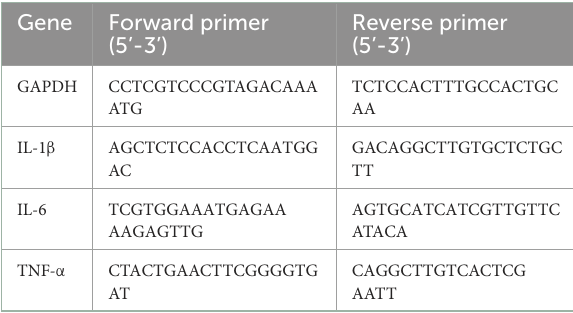
TABLE 1 Sequences of primers used for RT-PCR.